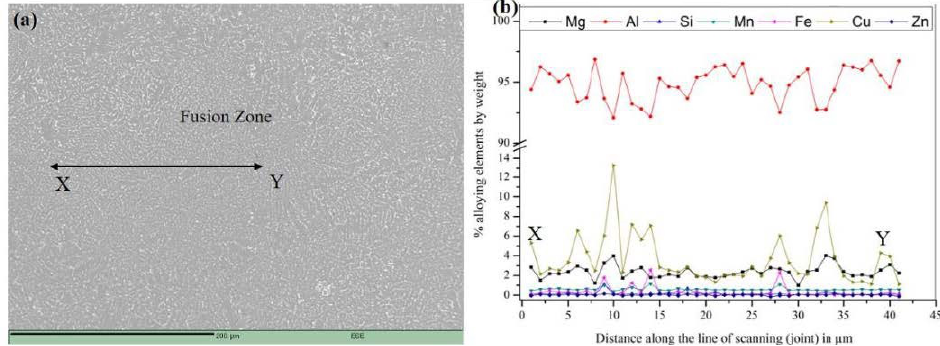
Figure 10. EPMA in FZ ( a ) BSE microstructure; ( b ) elemental distribution along path X.Y.